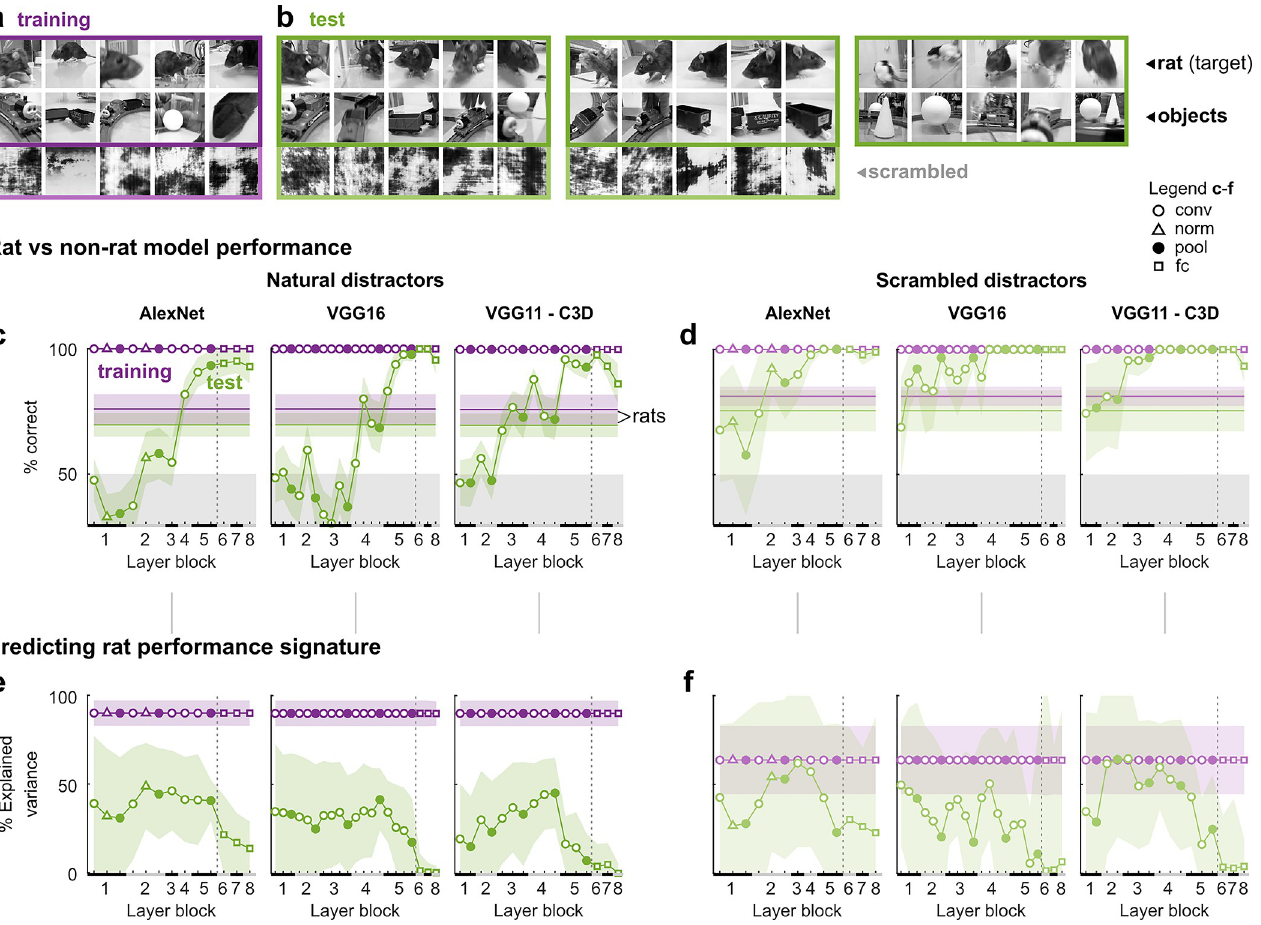
Fig 4. Mid-level convolutional layers are required for generalization in a rat versus non-rat categorization task of natural videos in Vinken et al. [6]. ( a , b ) Single frames of all the training (a) and test (b) videos that rats were asked to classify in the behavioral task. Each rat was trained with a subset of 15 videos (purple), and tested for generalization with 40 novel videos (green). Ten test videos (the 5 pairs with natural distractor in the left-most green rectangle) were modified to further probe the rats, for example by reducing playback speed to 25% or equalizing average pixel values in the lower-half of the videos [see 6]. ( c , d ) Average percentage correct classification of rat versus non-rat frame bin pairs by models incorporating increasingly more DNN layers from AlexNet, VGG16, and VGG11-C3D (the X-axis indicates the highest DNN layer) and for natural (c) and scrambled (d) distractors separately. Performance is evaluated on the training set (purple; all 50 target-distractor combinations) as well as the test set (green; the 25 tested target-distractor pairs, with 25% playback speed and pixel value modifications for 5 pairs [see (b)]). Black and grey bars on the X-axis indicate layer blocks and markers indicate layer types (see legend insert); the division between convolutional and fully connected layer blocks is indicated by a dashed line. Horizontal lines indicate the average behavioral performance across rats. ( e , f ) Percentage variance in performance across target-distractor pairs explained by each DNN layer (estimated by a linear mapping fit on the training set data and stimuli only) from AlexNet, VGG16, and VGG11-C3D (left to right) and for natural (e) and scrambled (f) distractors. Same conventions as in as in c,d. All error bounds are 95% confidence intervals calculated using Jackknife standard error estimates (resampling target-distractor pairs).